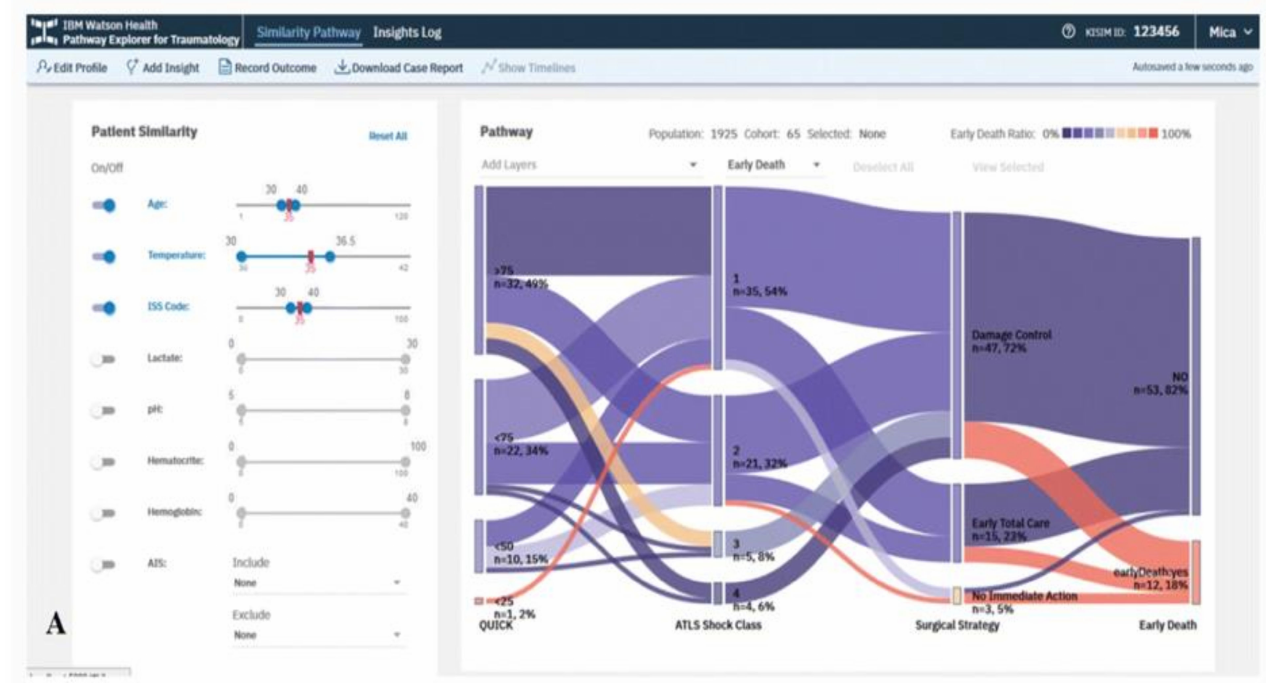
Figure 3. The screenshot of the VA system developed by Mica et al. [35] shows the pathway of the early death outcome of a hypothetical patient with an age of 35 years, an ISS of 35, and a temperature at admission of 35 ◦ C using a Sankey diagram. Source: Reprinted with permission from ref. [35], Copyright